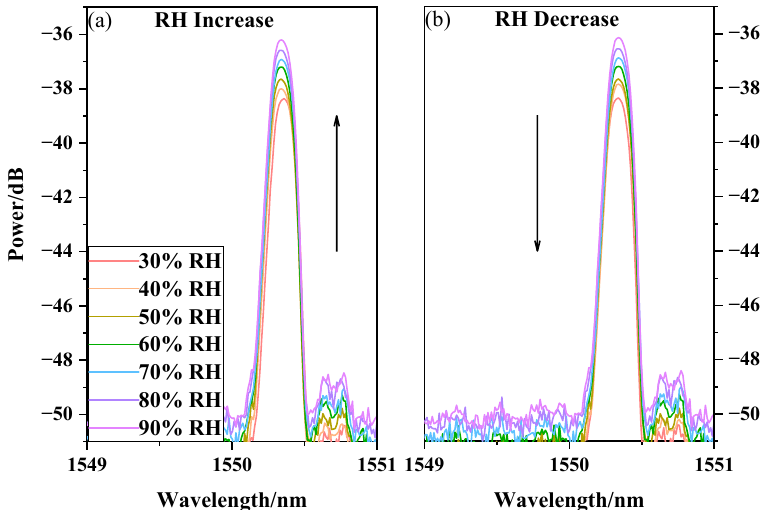
Figure 8. PVA nanofiber film humidity response with RH increase and decrease. ( a ) RH Increase; ( b ) RH Decrease.